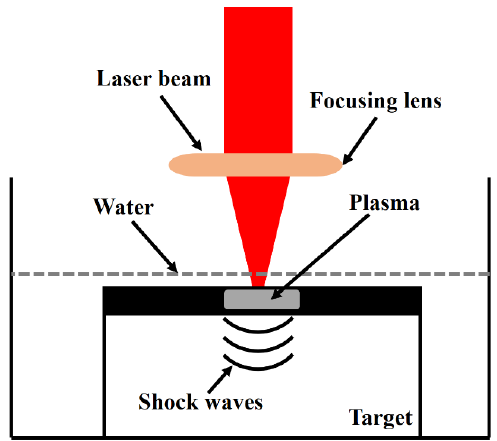
Figure 8. Laser shock peening schematic based on the data provided in Reference